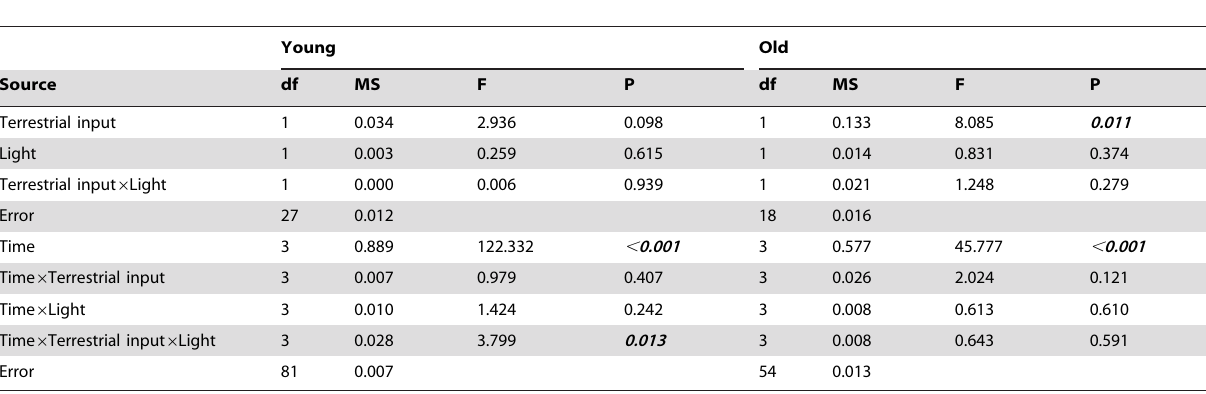
Summary table of repeated measures two factor ANOVA testing for the effect of light and terrestrial invertebrate input on the seasonal growth of young and old trout.